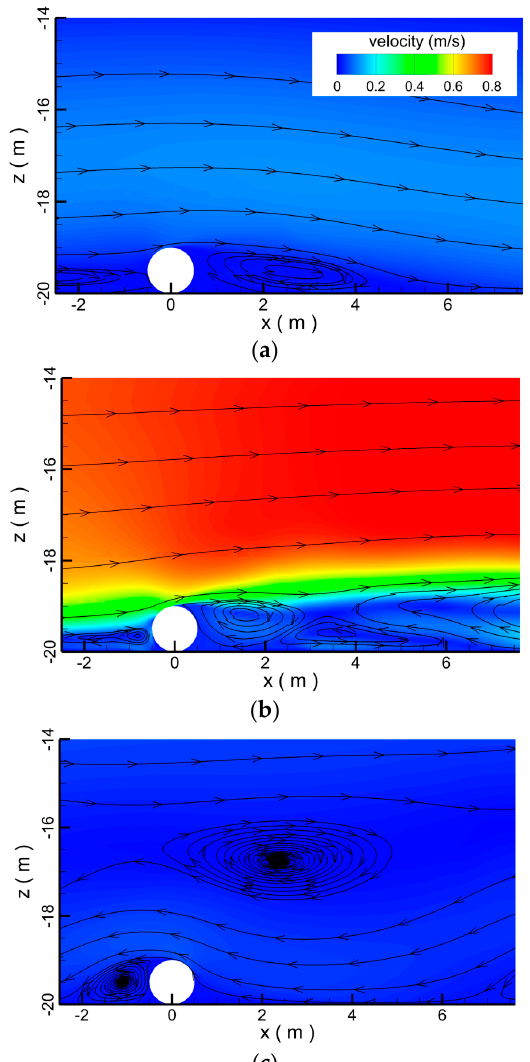
Figure 11. Simulated 2D flow field at the pipe. The flow in ( a – c ) are in order of time t 1 , t 2 and t 3 .